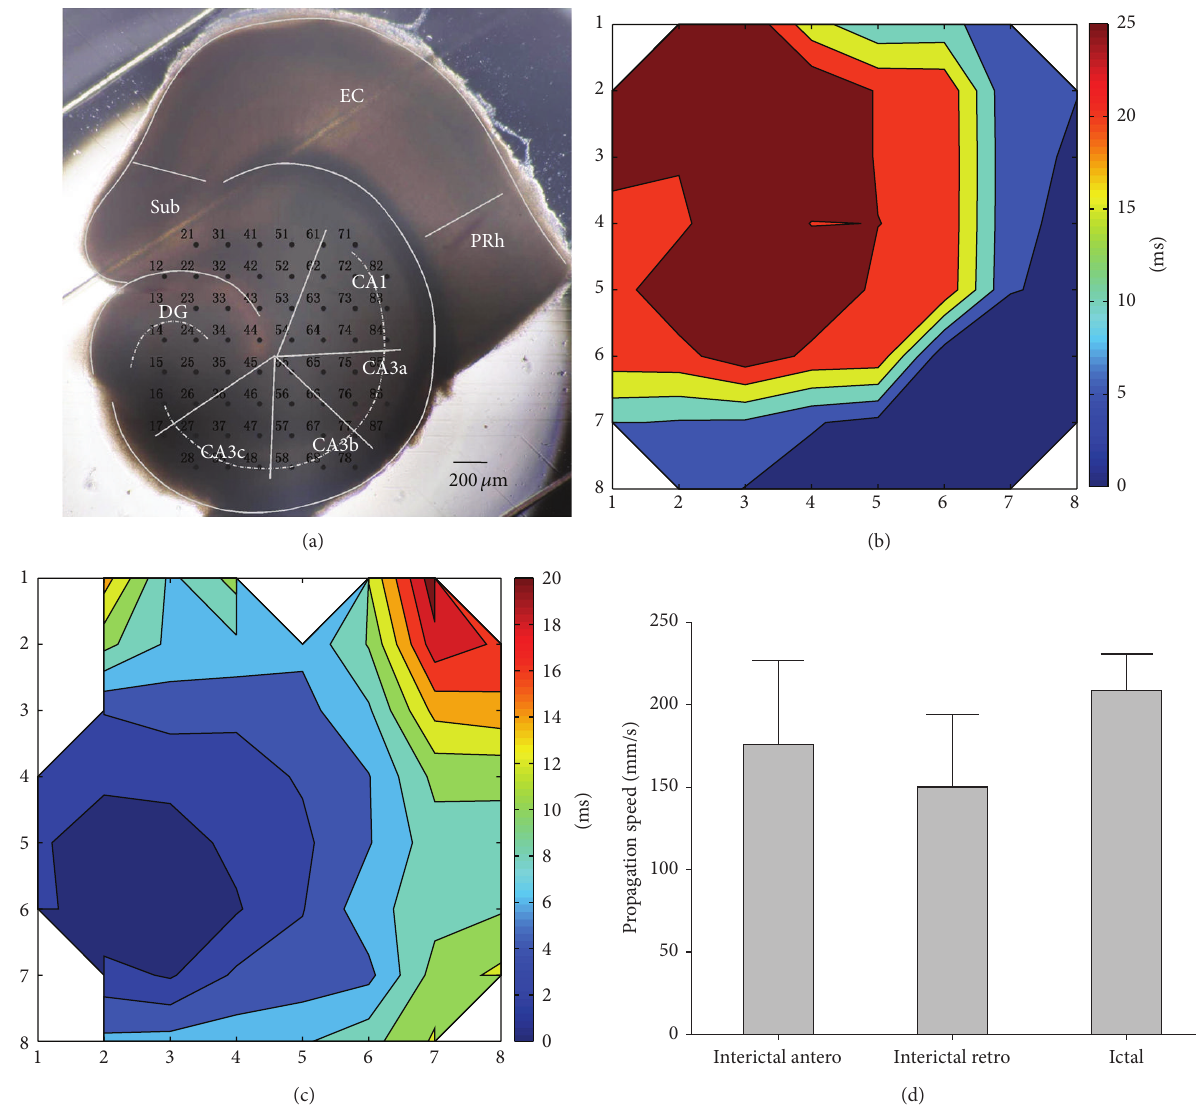
Figure 3: Initiation and propagation of interictal and ictal discharges in the hippocampal area of the combined EC-hippocampal slices. (a) An image of an example of a combined slice mounted on MEA. (b) Contour plot of averaged time delays of the FP relative to signals of electrode number 85. The X and Y coordinates denote the positions of electrodes. (c) Contour plot of averaged time delays of the FP relative to signals of electrode number 25. (d) Averaged propagation speeds of interictal discharges and ictal discharges in the combined slices. antero: anterograde propagation speed; retro: retrograde propagation speed ( 𝑃 > 0.05 , ANOVA, 𝑛 = 5 ).